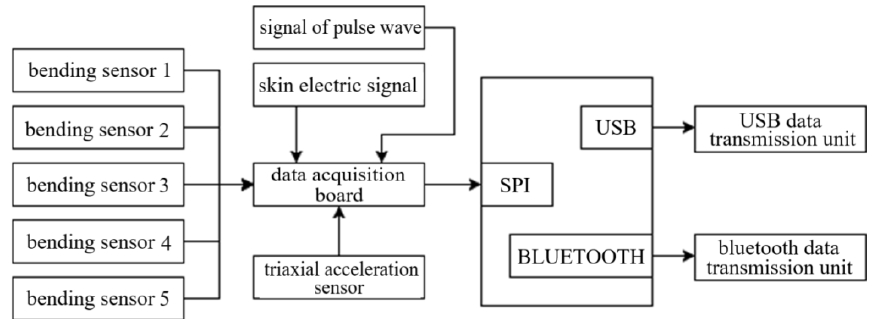
Figure 6. Data glove hardware structure framework.